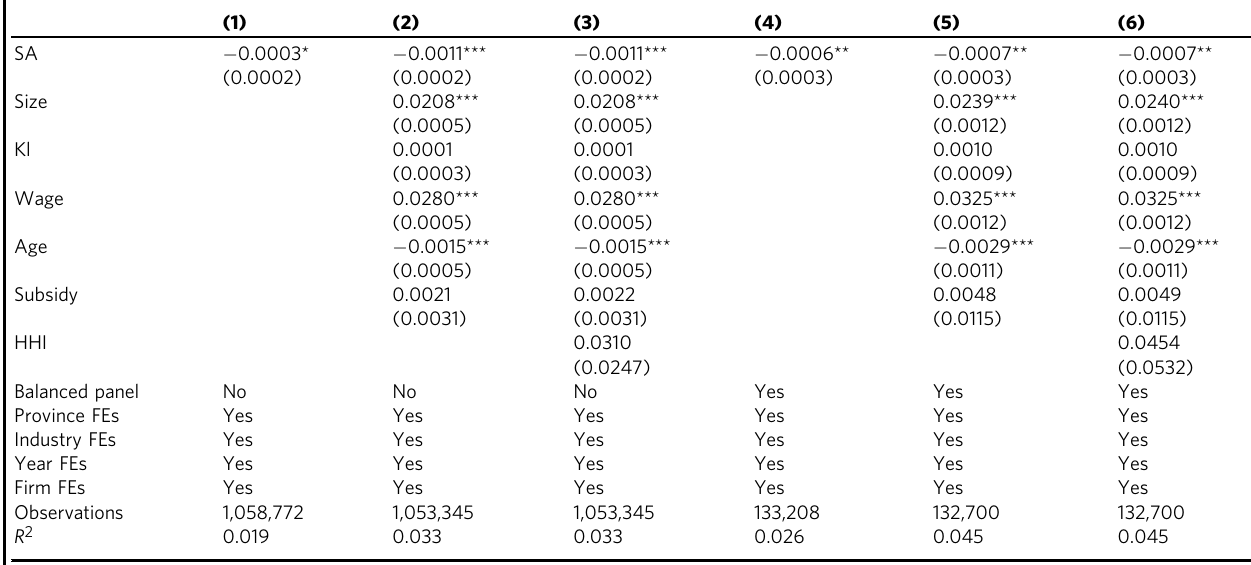
Table 4 Benchmark regression